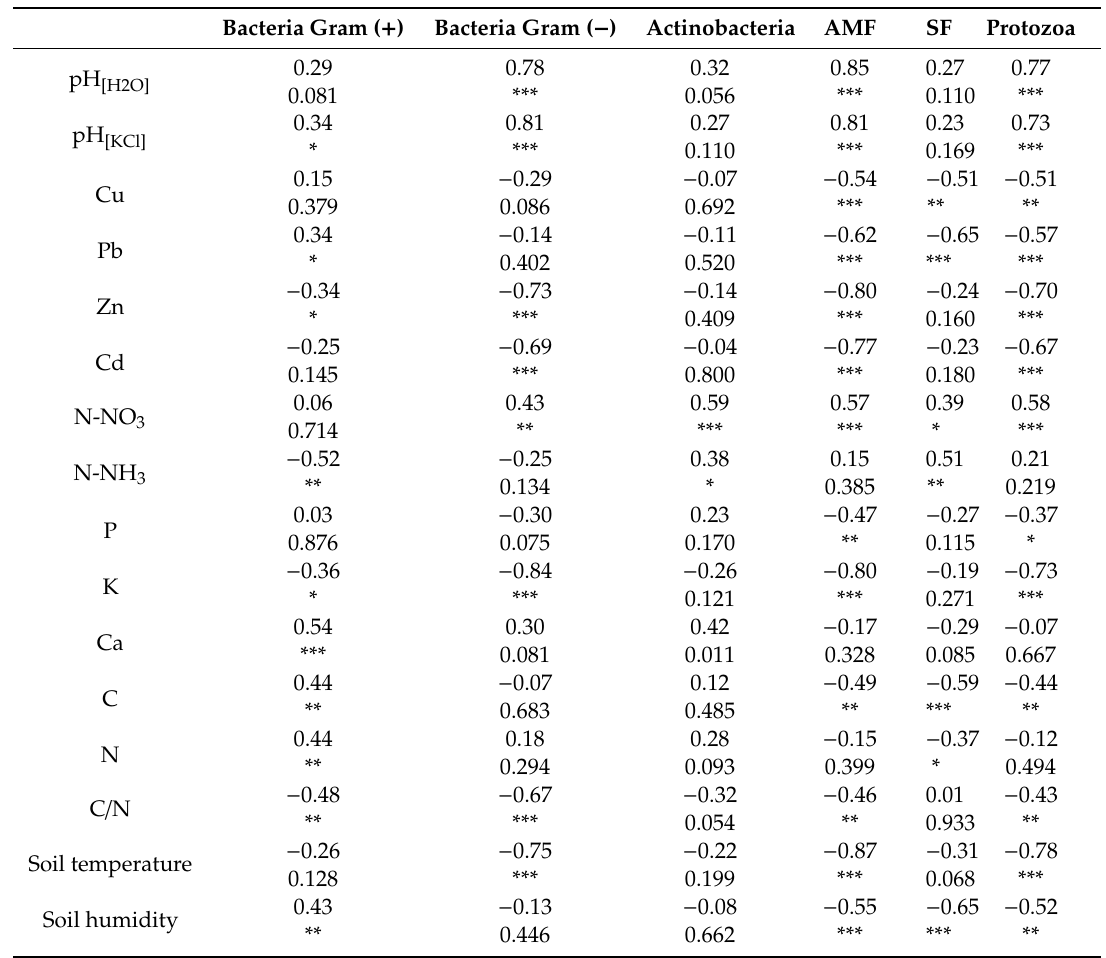
Table 4. Spearman rank correlation matrix (r S and p-value) of biomass of soil microorganisms (bacteria gram-positive, bacteria gram-negative, actinobacteria, arbuscular fungi(AMF), soil fungi(SF), protozoa) and the chemical composition of soil. The following symbols are used to indicate level of significance: